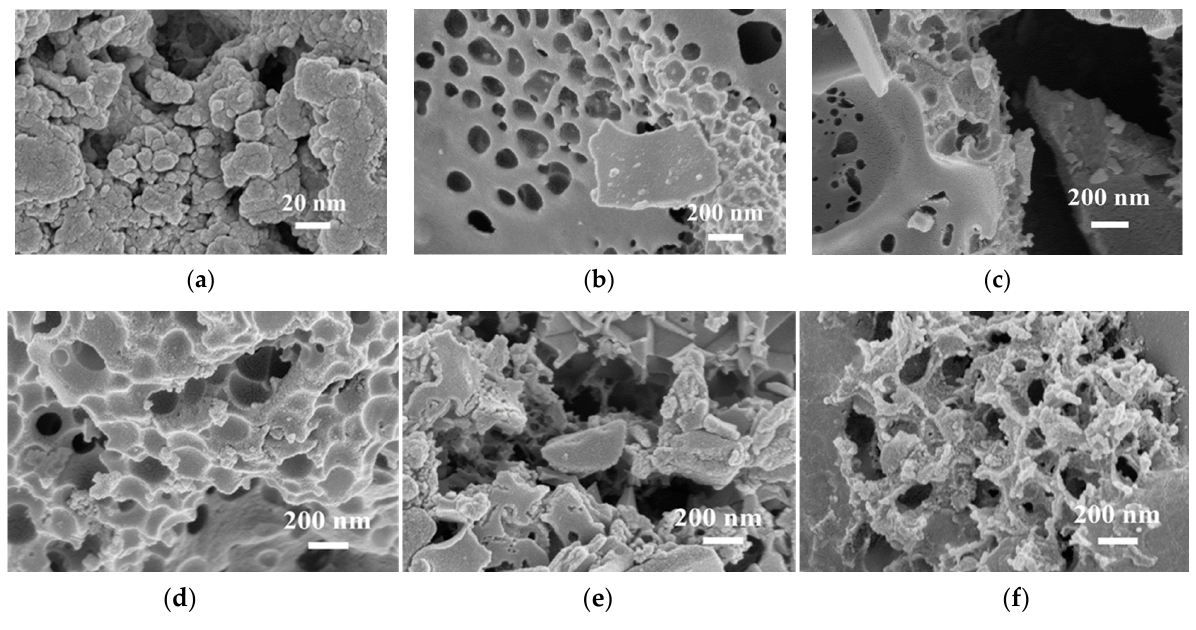
Figure 1. SEM image of coconut shell after activation with KOH at 700 °C: ( a ) C/KOH-0, ( b ) C/KOH-1, ( c ) C/KOH-2, ( d ) C/KOH-3, ( e ) C/KOH-4 and ( f ) C/KOH-5.